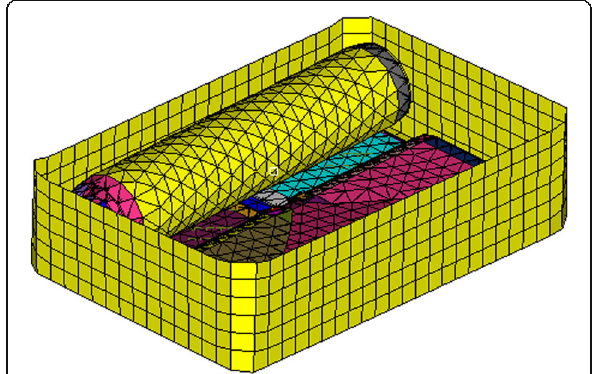
Fig. 8 The finite element model of the airbag and box